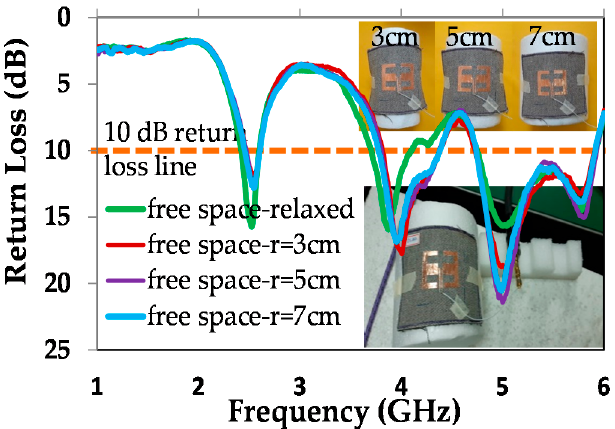
Figure 8. Measured behaviour of the antenna under different deformations.